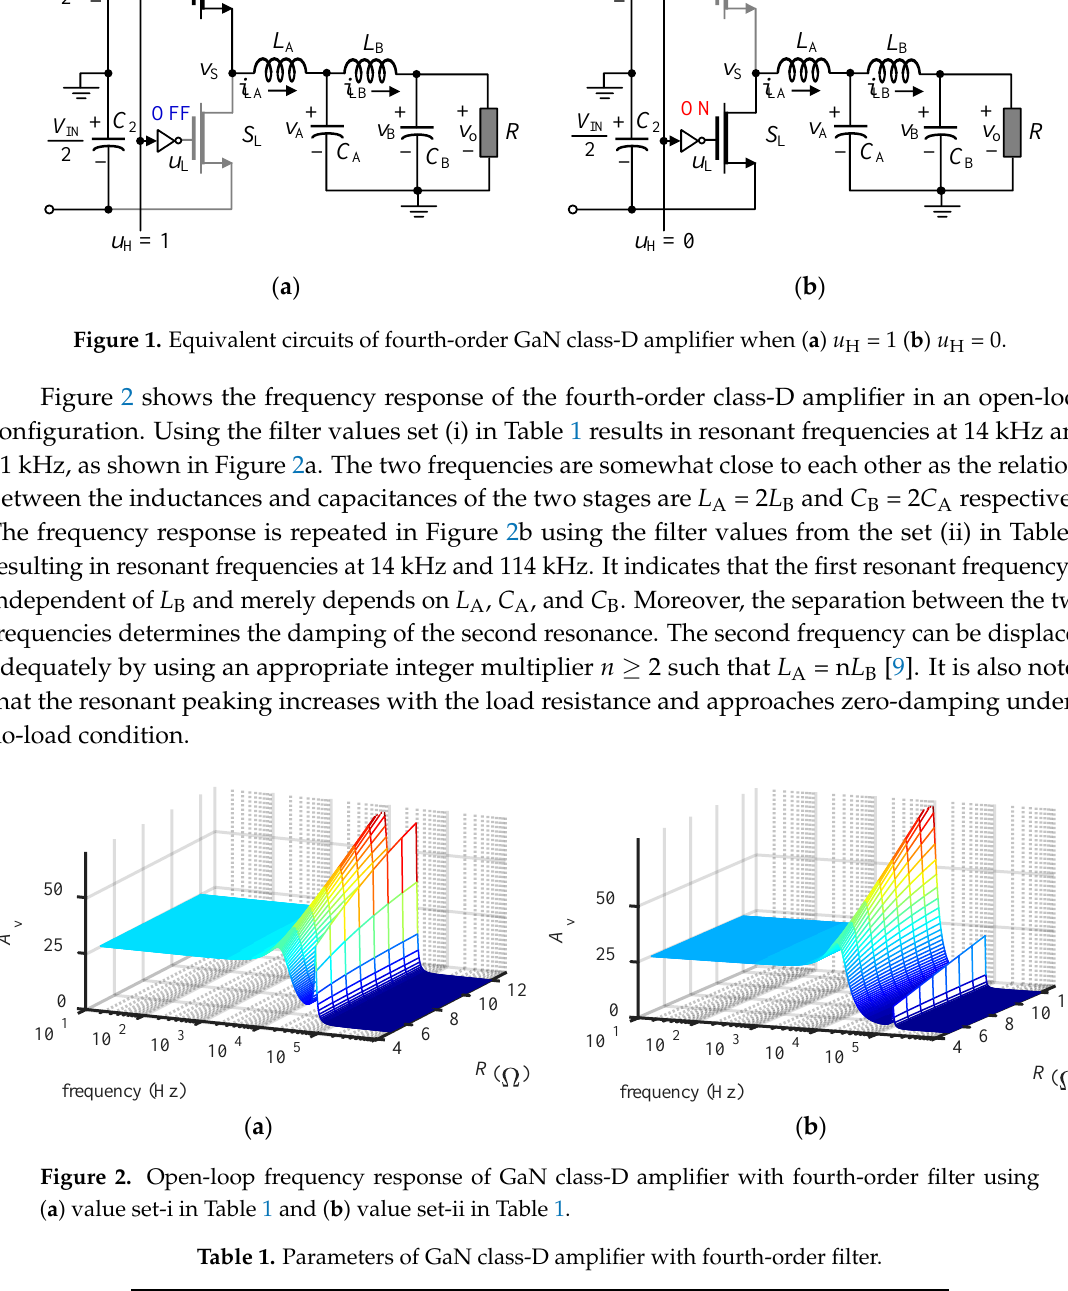
Figure 1. Equivalent circuits of fourth-order GaN class-D amplifier when ( a ) u H = 1 ( b ) u H = 0.